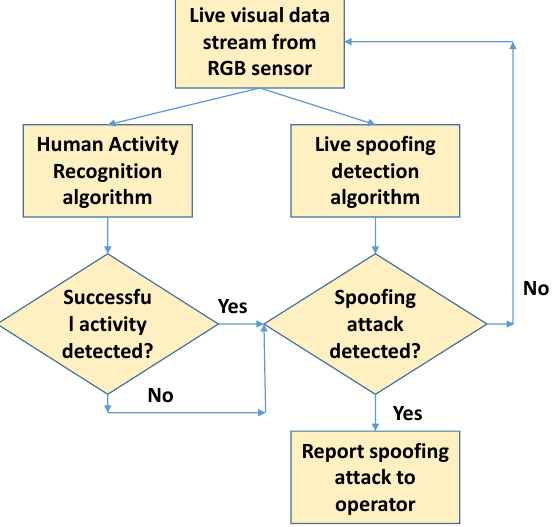
Figure 2. Proposed workflow for spoofing detection in HAR applications: a lightweight spoofing detection algorithm is run in parallel to the HAR algorithm for live detection of spoofing attack